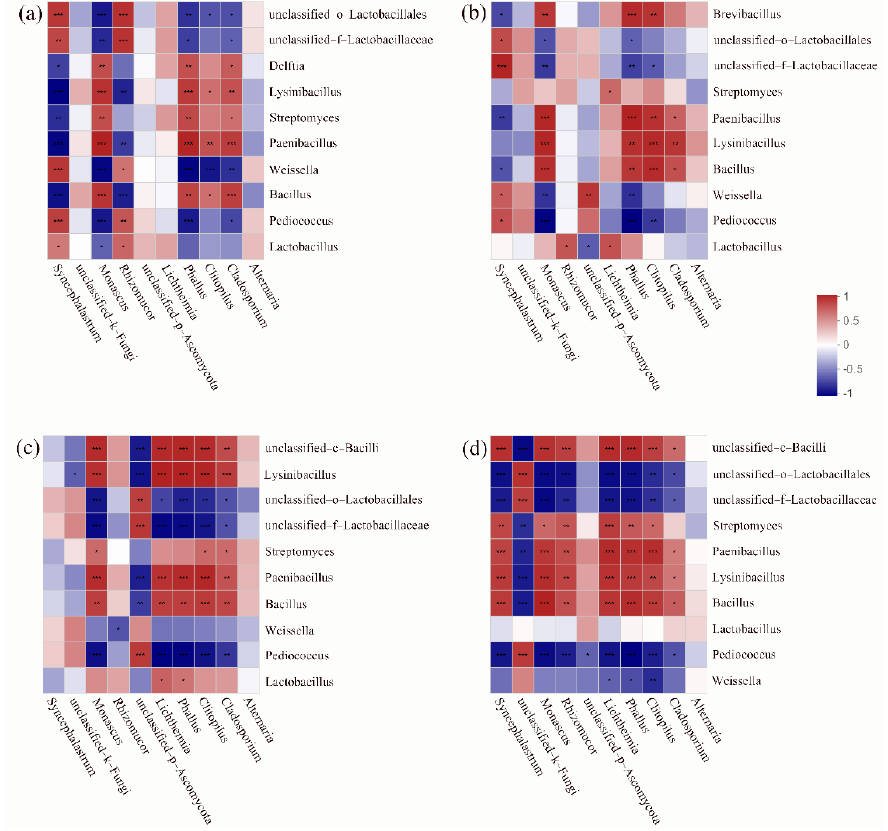
Figure 6. Correlation analysis of bacterial and fungal community compositions at genus levels. ( a ) BP100; ( b ) BP90; ( c ) BP80; ( d ) BP65. * p < 0.05, ** p < 0.01, *** p <